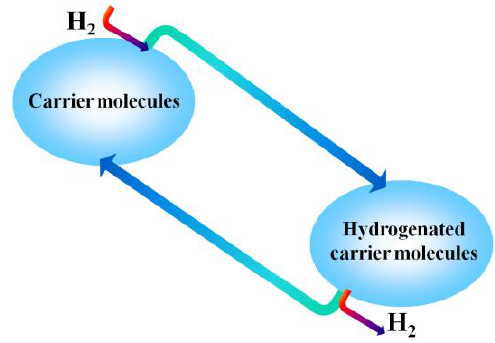
Figure 7. Hydrogen carrier reaction pathways.